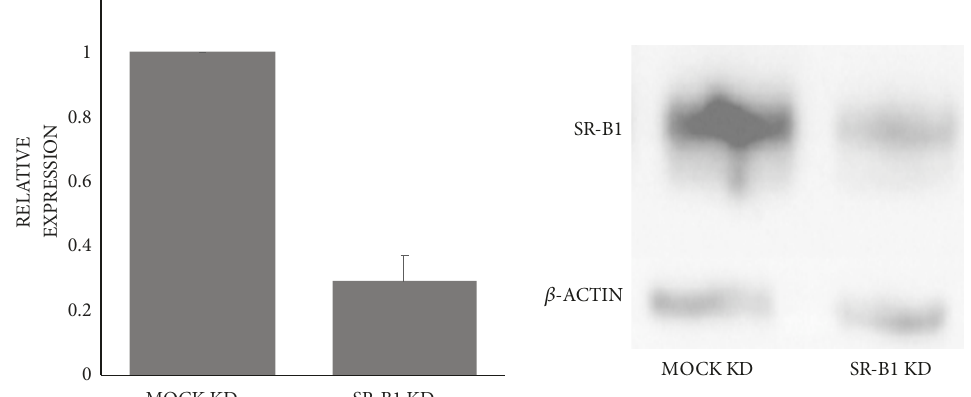
Figure 3: Scavenger receptor Class B Type 1 expression in HepG2 cells. Using esiRNA, SR-B1 levels were knocked down to 29 ± 8% of mock knockdown (KD) control levels (n=4, ∗ ∗ ∗ ∗ ∗∗ p <